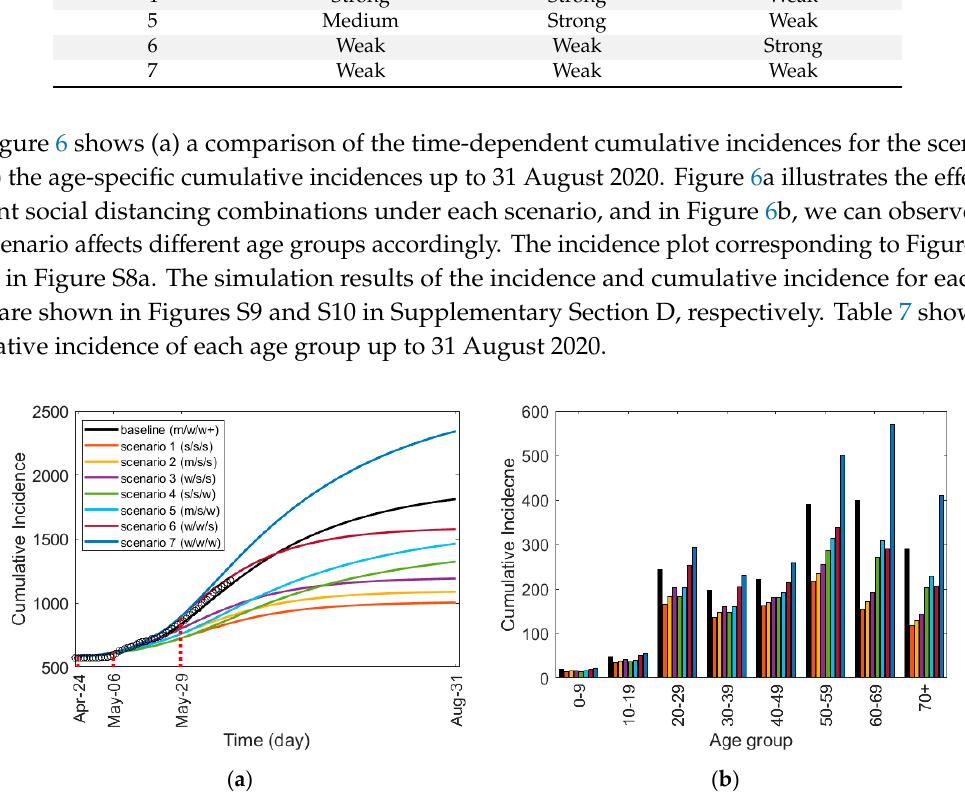
Figure 6. Cumulative Incidence for scenarios of social distancing: ( a ) the time-dependent